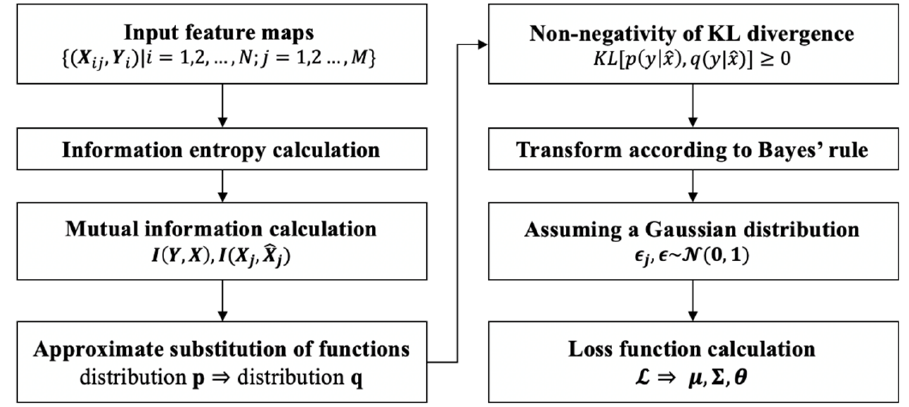
Figure 3. Flow chart of the feature extraction module based on the information bottleneck theory.